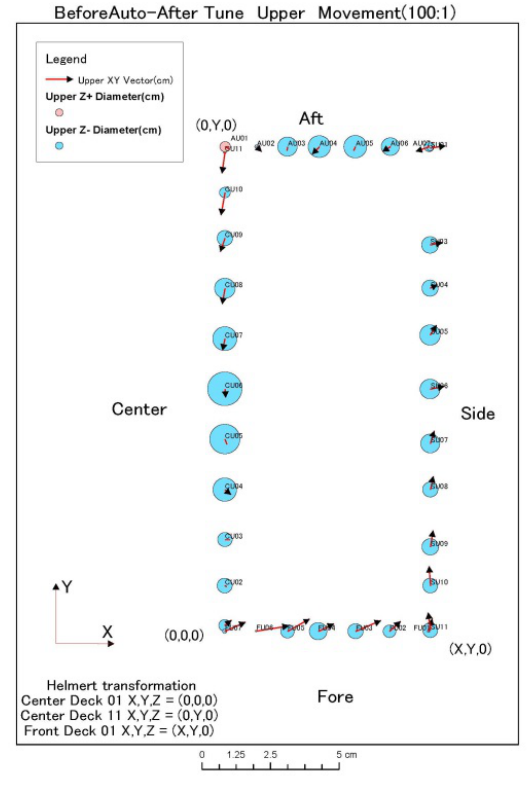
Figure 7. [A]Before Auto/[F]After Turn